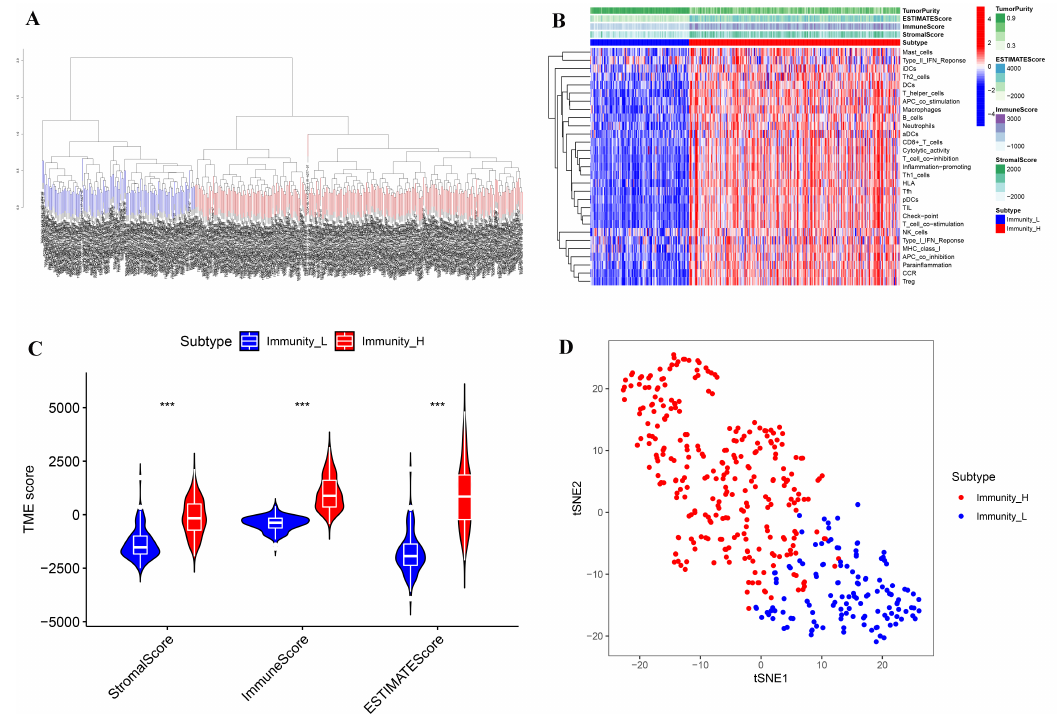
Figure 1. Immune subtypes and clustering in BLCA patients. ( A ) Based on the results of ssGSEA, BLCA patients were divided into Immunity_H and Immunity_L by a hierarchical clustering algorithm. ( B ) Immune infiltration and tumor microenvironment landscape of TCGA-BLCA patients. ( C ) The comparison of ImmuneScore, StromalScore, and ESTIMATEScore in Immunity_H and Immunity_L. ( D ) Verification of immune subtypes by tSNE. *** p <